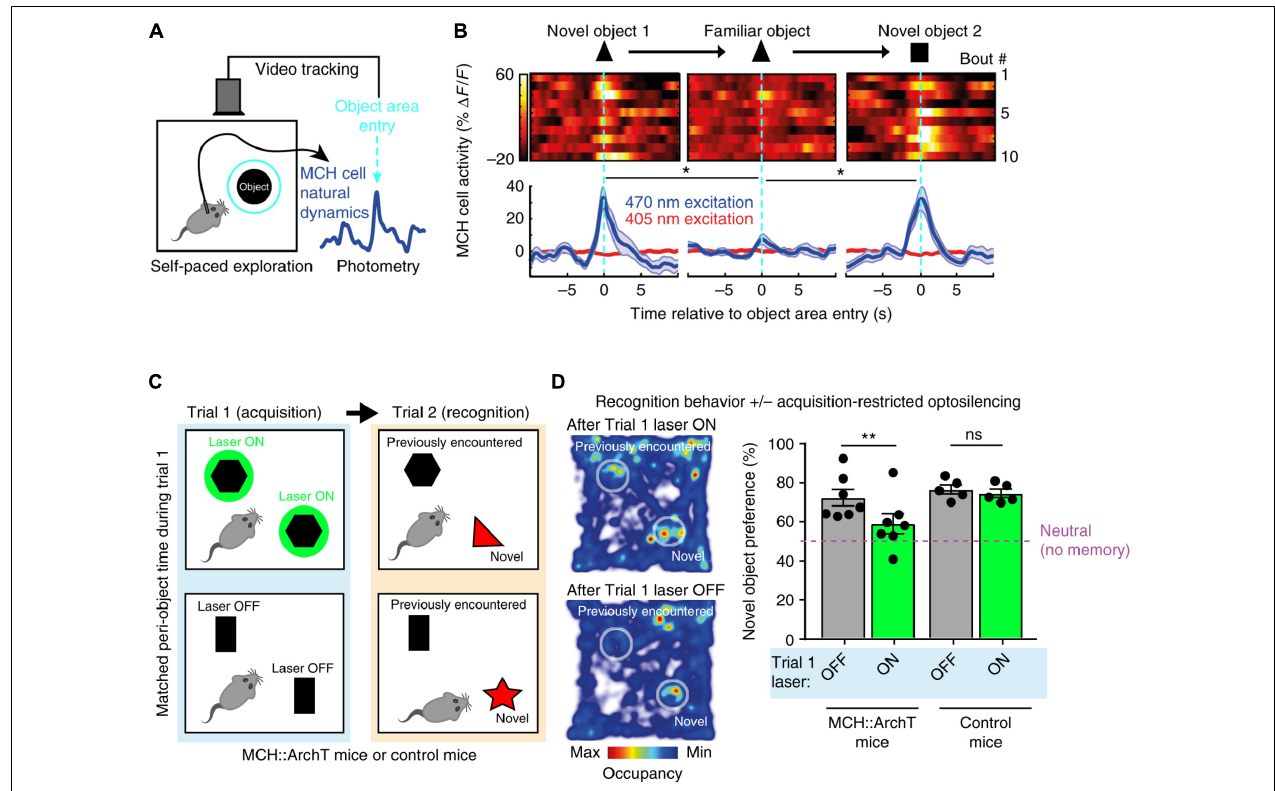
FIGURE 3 | Role of exploration-associated MCH cell activity in object recognition memory. (A) Schematic of MCH-GCaMP recording aligned to self-paced object exploration. (B) MCH cell activity associated with exploration of novel (but not familiar) objects. (C) Schematic of MCH-ArchT cell silencing selectivity during self-paced object exploration. (D) No object recognition after MCH cells were silenced upon the earlier object exploration. Source: Kosse and Burdakov